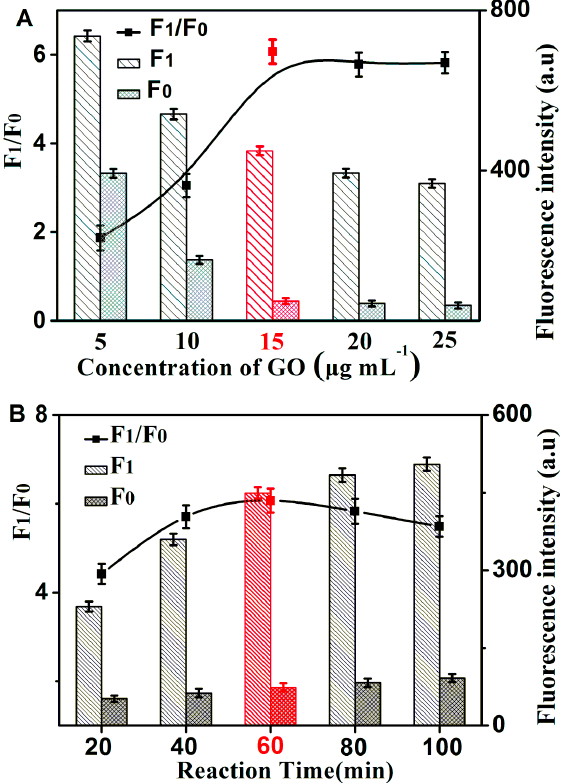
Figure 3. ( A ) The fluorescence intensity of this assay under different GO concentrations. ( B ) The